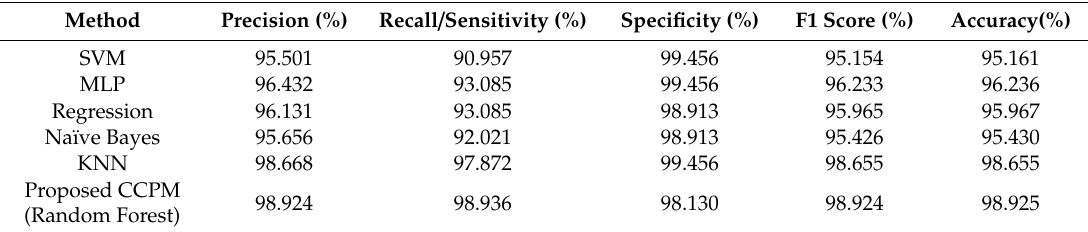
Table 8. Performance evaluation results based on iForest and SMOTE for Biopsy.